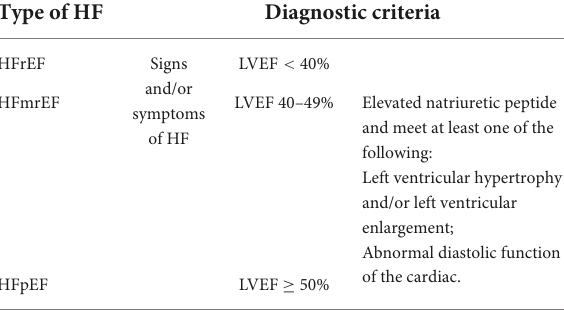
TABLE 2 Current diagnostic criteria for heart failure